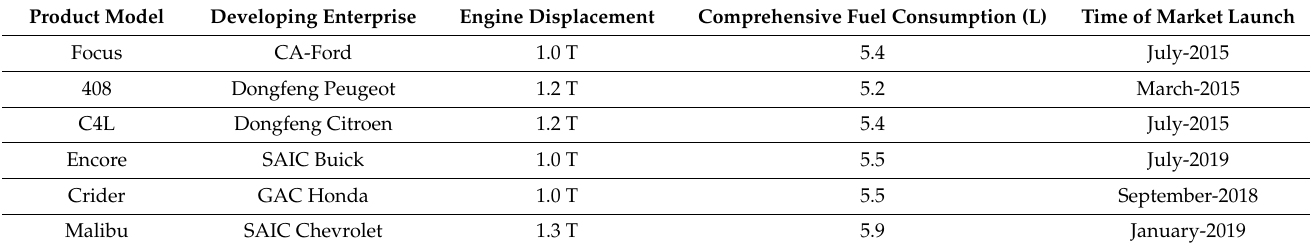
Table 1. Three-cylinder engine models and their